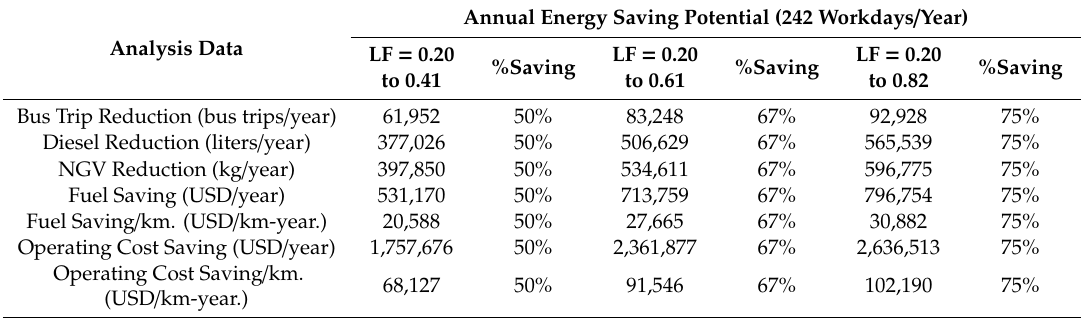
Table 6. Annual Energy Saving Potential after Applied PBRU on Rama 2 Road during the Off-peak Period.